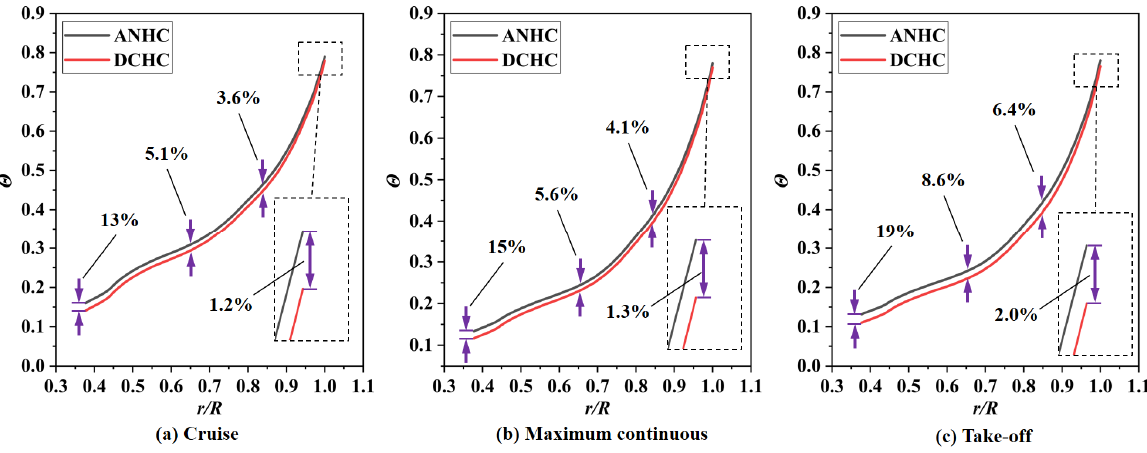
Figure 34. Dimensionless metal temperature recovery from compensation design.